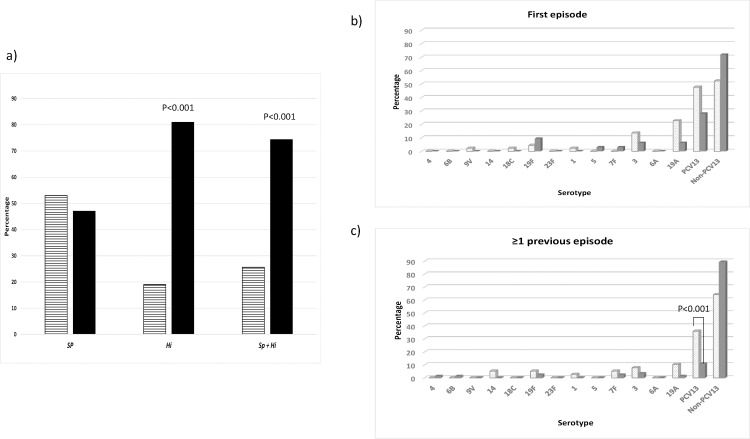
Isolation rates of S. pneumoniae and/or H. influenzae in children with and without history of previous otitis episodes: a) Percentage of children suffering a first episode of OM (striped columns) and with past history of otitis episodes (black columns) among children with OM by S. pneumoniae, H. influenzae and S. pneumoniae + H. influenzae; b) PCV13 serotypes in OM by S. pneumoniae (dotted columns) or S. pneumoniae + H. influenzae (grey columns) among children with a first episode of OM; c) Same as b) for children with past history of otitis.